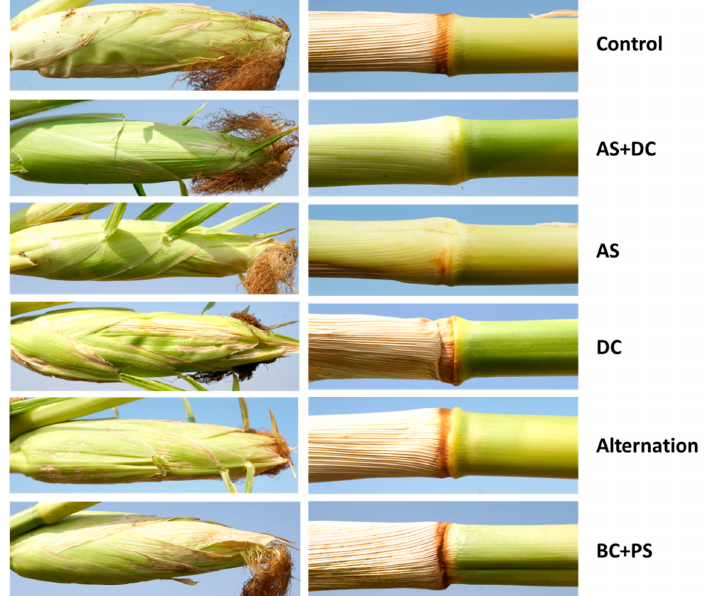
Figure 4. Stem surface and cob symptoms (Amir, summer 2018). Color changes of the plants’ lower stems (near the first above-ground internode, right) and cobs (left). Photos were made of representative plants from the field experiment at 71 DAS (16 DAF).